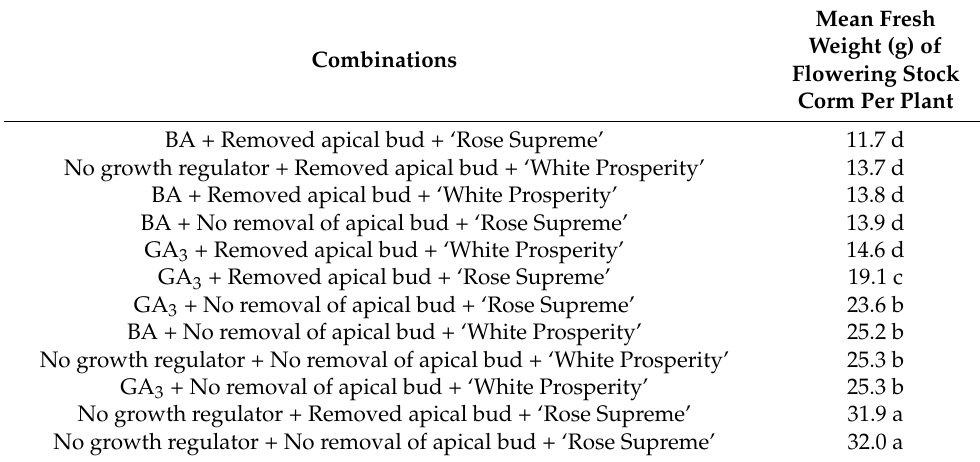
Table 2. Sorted mean fresh weigh of flowering stock corm (from low to high) for the combination of growth regulators, apical bud removal, and varieties. Letters behind the numbers are results from the Duncan’s Multiple Range Tests.